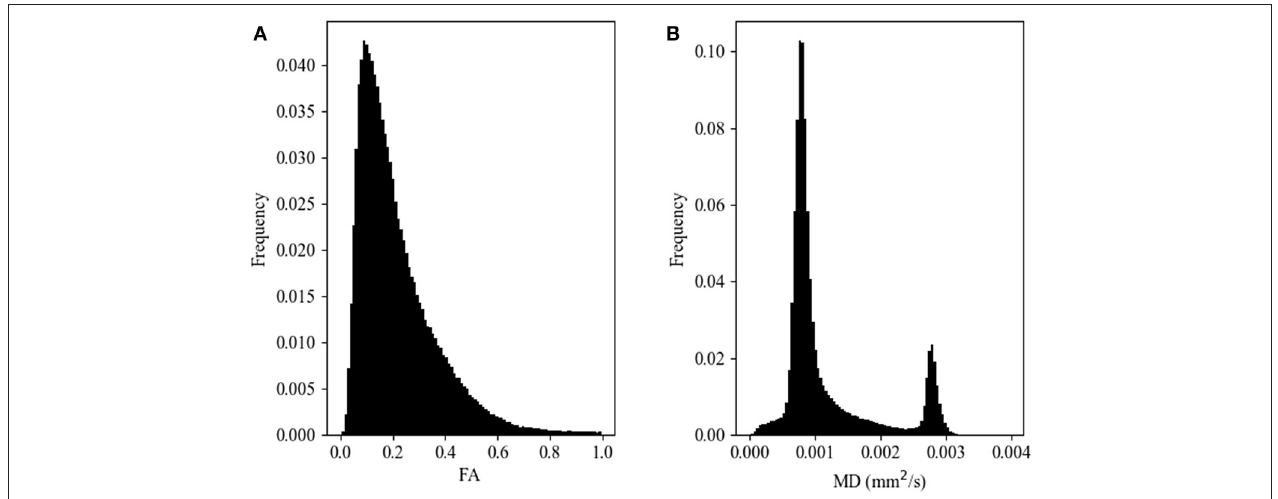
FIGURE 1 | Representative histograms of diffusion metric map values for fractional anisotropy, FA (A) and mean diffusivity, MD (B) maps. These data arise from a single subject scanned on a 1.5T GE scanner at a b -value of 1,000 s/mm 2 and 25 gradient directions.